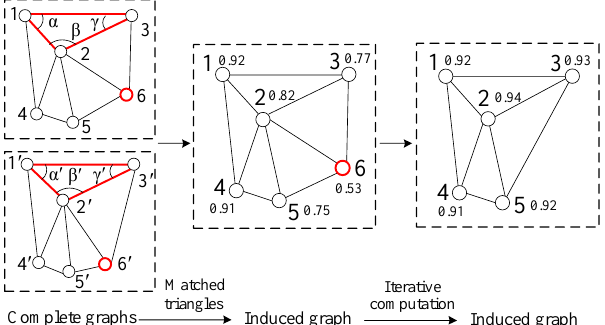
Figure 3. The main workflow of building and iterating the induced graph.